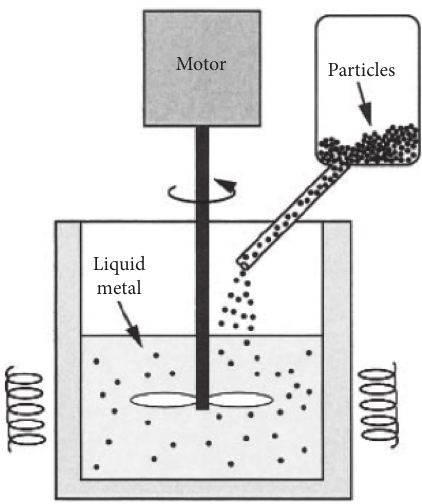
Figure 1: Stir casing setup used for the manufacturing of MMCs